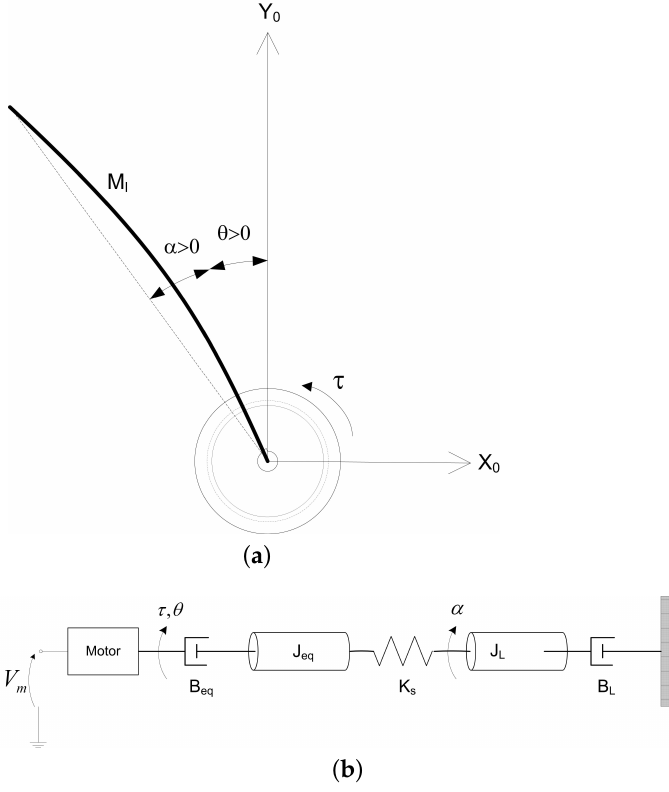
Figure 3. Rotary flexible link: ( a ) rotary flexible link angles; ( b ) rotary flexible link